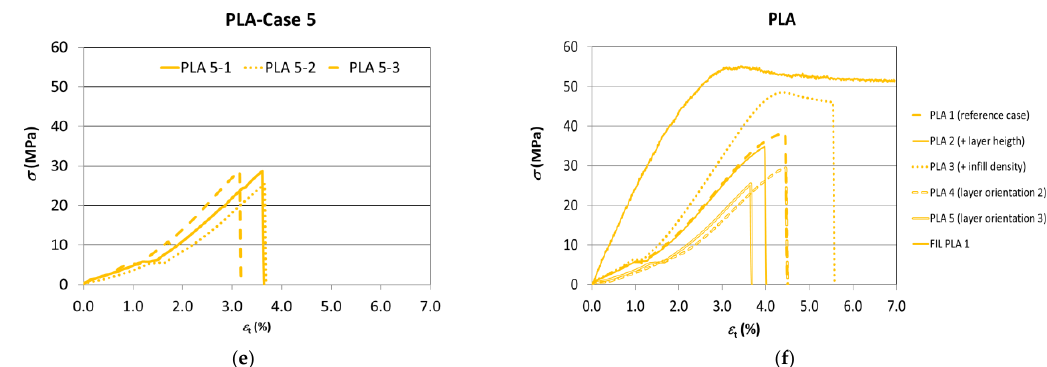
Figure 7. The stress – strain curves (PLA). ( a ) Case 1; ( b ) Case 2; ( c ) Case 3; ( d ) Case 4; ( e ) Case 5; ( f ) the comparison of the results with the intermediate values of each series of test specimens.